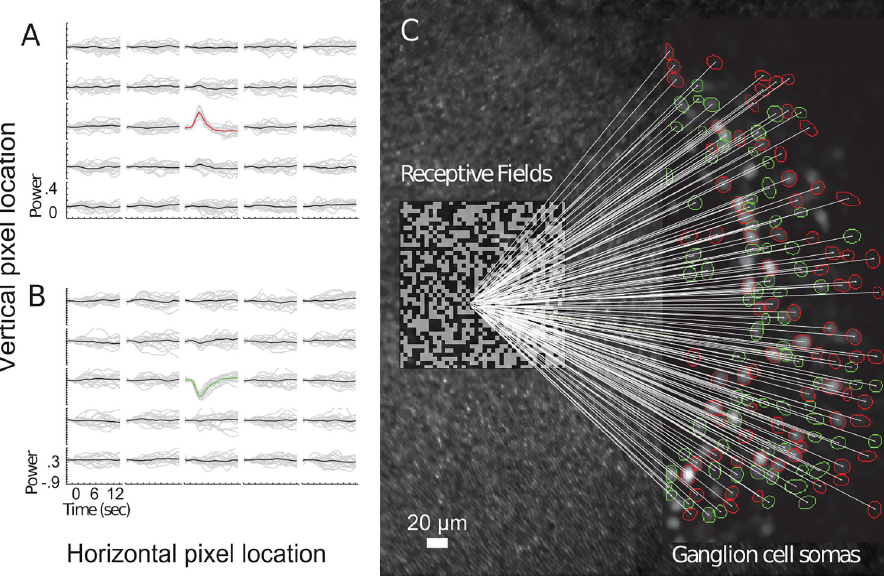
Fig 2. Mapping GC impulse responses. a.) and b.). Two examples illustrating the method of calculating the spatio- temporal response to individual checks of the stimulus. These images show the temporal response to light in a 5 by 5 array of checks centered on the check that resulted in the maximal response. A positive (ON-dominant) response is seen in Fig 2A) and a negative (OFF-dominant) response in Fig 2B). In each plot, grey traces show individual responses to 10 presentations of the check, whereas dark lines show mean response to the 10 presentations, with non- significant responses shown as black and significant responses shown as red (ON-dominant) or green (OFF- dominant). c.) Projection from centroids of receptive fields (RF) near the fovea center to RGCs measured using white- noise analysis. The background of the figure shows cones imaged by reflectance imaging across the entire AO field. All RGCs recorded in this example data set are on the temporal side of the fovea. The location of the checkerboard stimulus illustrated in Fig 1 is shown to the center left of the figure, covering the center of the fovea. Subsequent datasets were recorded RGCs nasally, inferior and superior to the fovea, and the complete data set is shown in Fig 3. Straight lines connect the pixel at the center of the RF to the RGC activated. The polarity of each RGC is indicated by the color of the contour around its soma (red, ON; green;